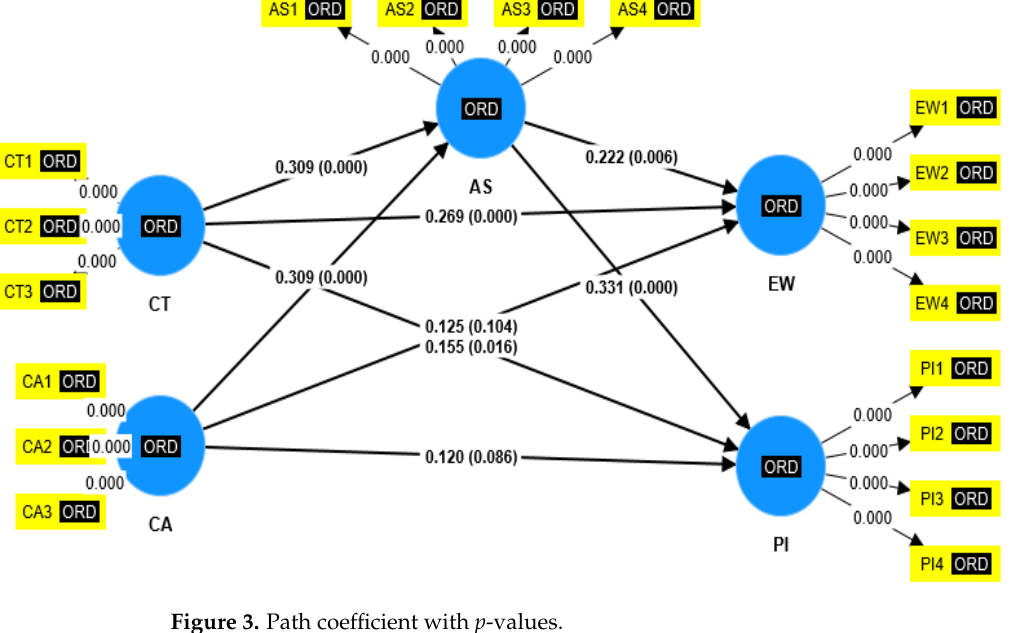
Figure 4. Path coefficient with t-values. 4.3. Mediation Effect More importantly, the assessment of variance described the endogenous latent vari- ables (i.e., electronic word of mouth and purchase intentions). The R-square value indi- cates the percentage of variation in the dependent factor that could be justified by one or more predictor variables [99]. In PLS-SEM, 0.60 can be considered a substantial and ac- ceptable value for R2, with 0.33 as mild and 0.19 as low [100]. Thus, the R2 value found for this work was 0.24, which was above the benchmark. 5. Conclusions, Implications, and Future Research 5.1. Conclusions and Implications This study found that corporate social responsibility trust and corporate social re- sponsibility awareness are statistically significantly related to bank customers’ electronic word of mouth and purchase intentions. According to Table 9, yielded results justify the combined effect along with T-statistics. This implies that attitude towards social media